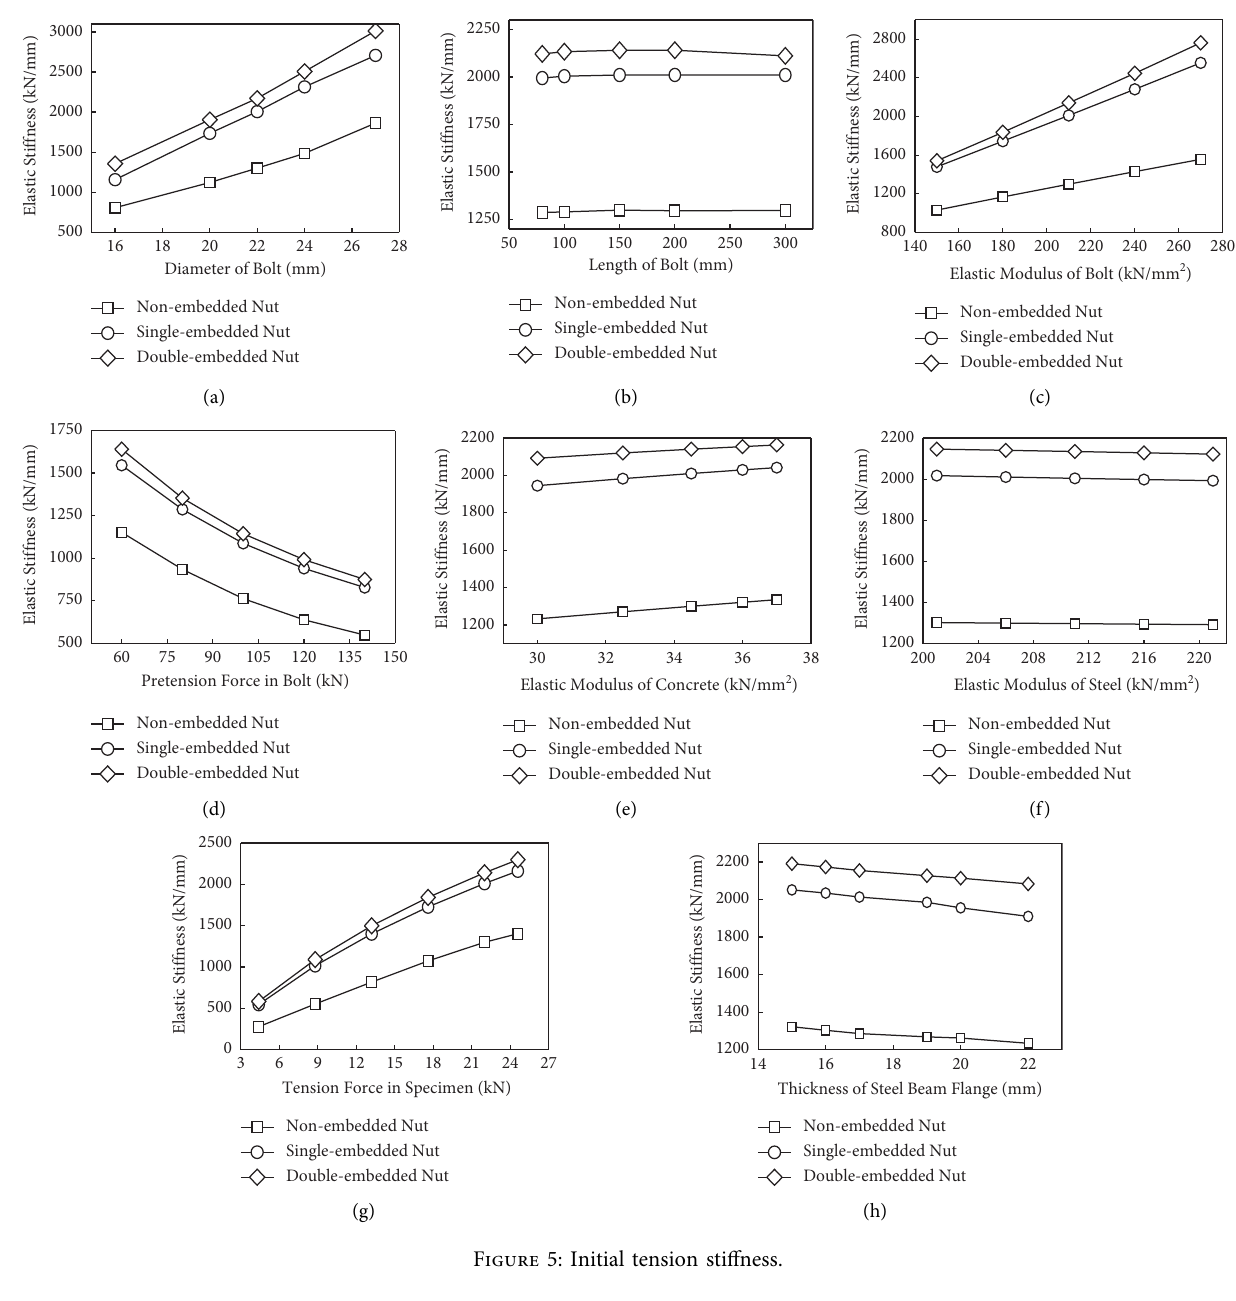
Figure 5: Initial tension